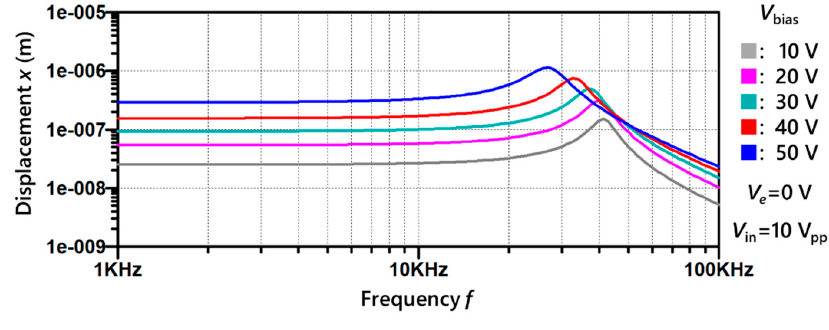
( a ) Figure 6. Cont ( a )